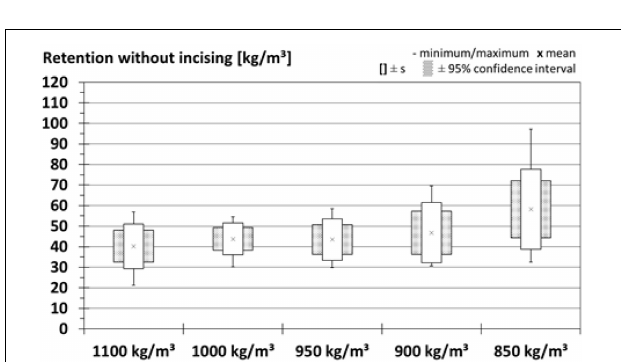
FIGURE 10 | Solution uptake of an alternative oily preservative in kg/m 3 for specimen without incising.